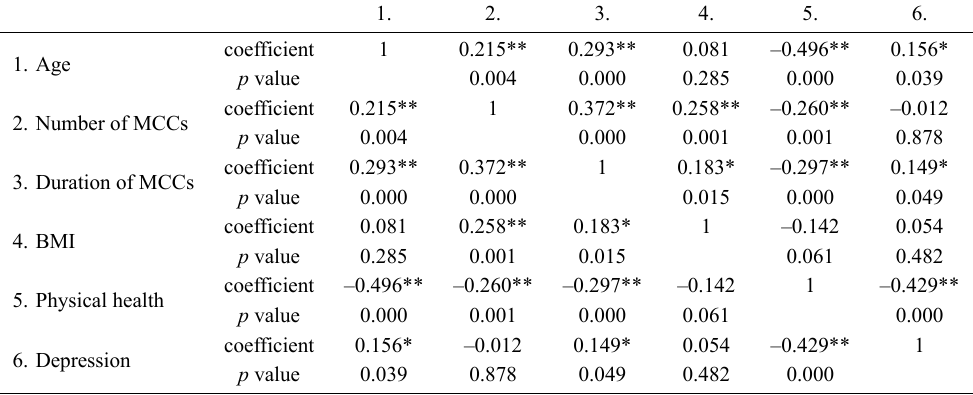
Table 3. Correlations of the observed variables in the female group (n = 175).